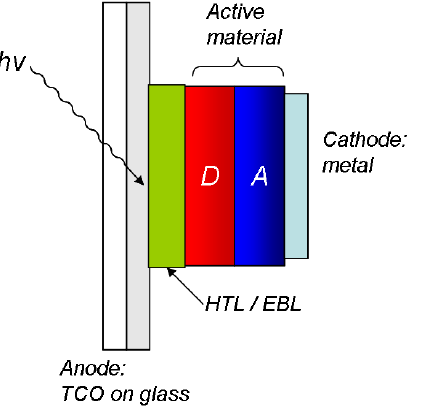
Figure 2. Structure of a bilayer organic photovoltaic cell. The material used for the anode is frequently a transparent conducting oxide (TCO) on glass. Exciton separation is encouraged by using a hole-transporting layer (HTL), which serves also as an electron-blocking layer (EBL). This layer allows holes to flow to the anode but not the electrons.